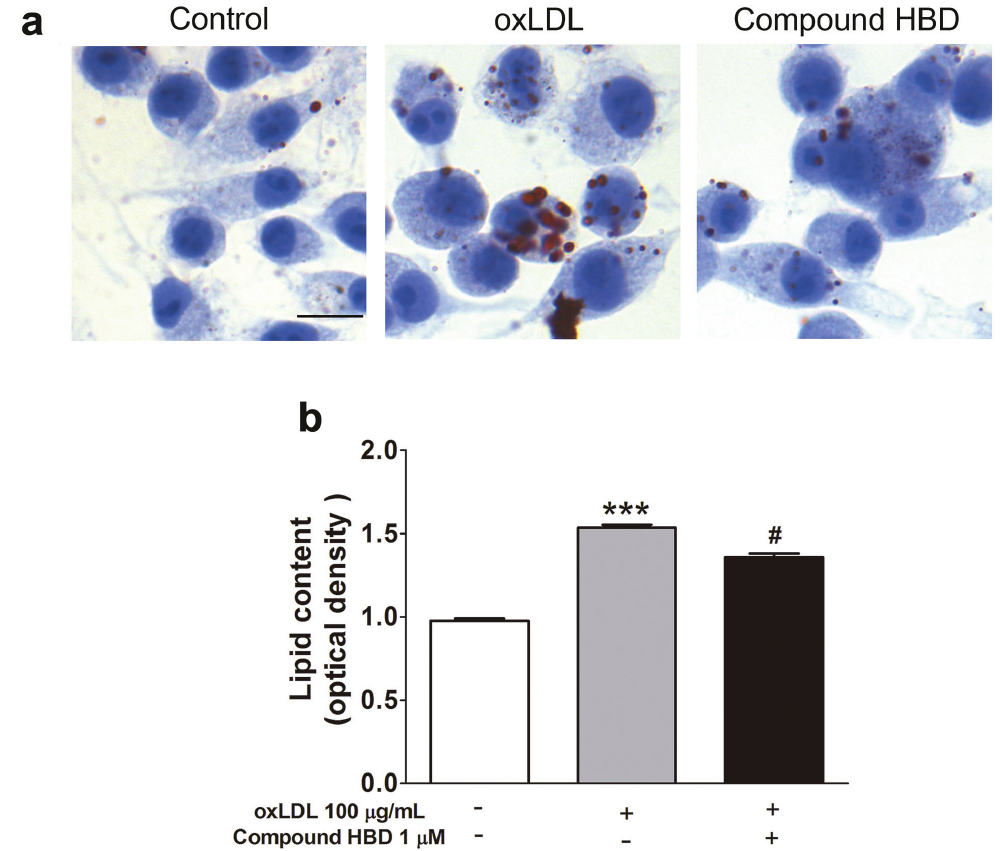
Figure 3 - Effect of Compound HBD on foam cell formation. ( a ) J774 macrophage cells were preincubated for 24 h with 1 µM of Compound HBD or vehicle, then, oxidized LDL (oxLDL) 100 µg/mL was added to the medium for 3 h. The cells were stained with Oil Red O and hematoxilin and observed under ligh microscope. Representative images were from three independent experiments. Scale bar, 10 µm. ( b ) Quantification of foam cells lipid content (optical density). The data presented were means ± SEM. *p < 0.001 compared with control cells and #p < 0.05 compared with oxLDL-treated cells (one-way